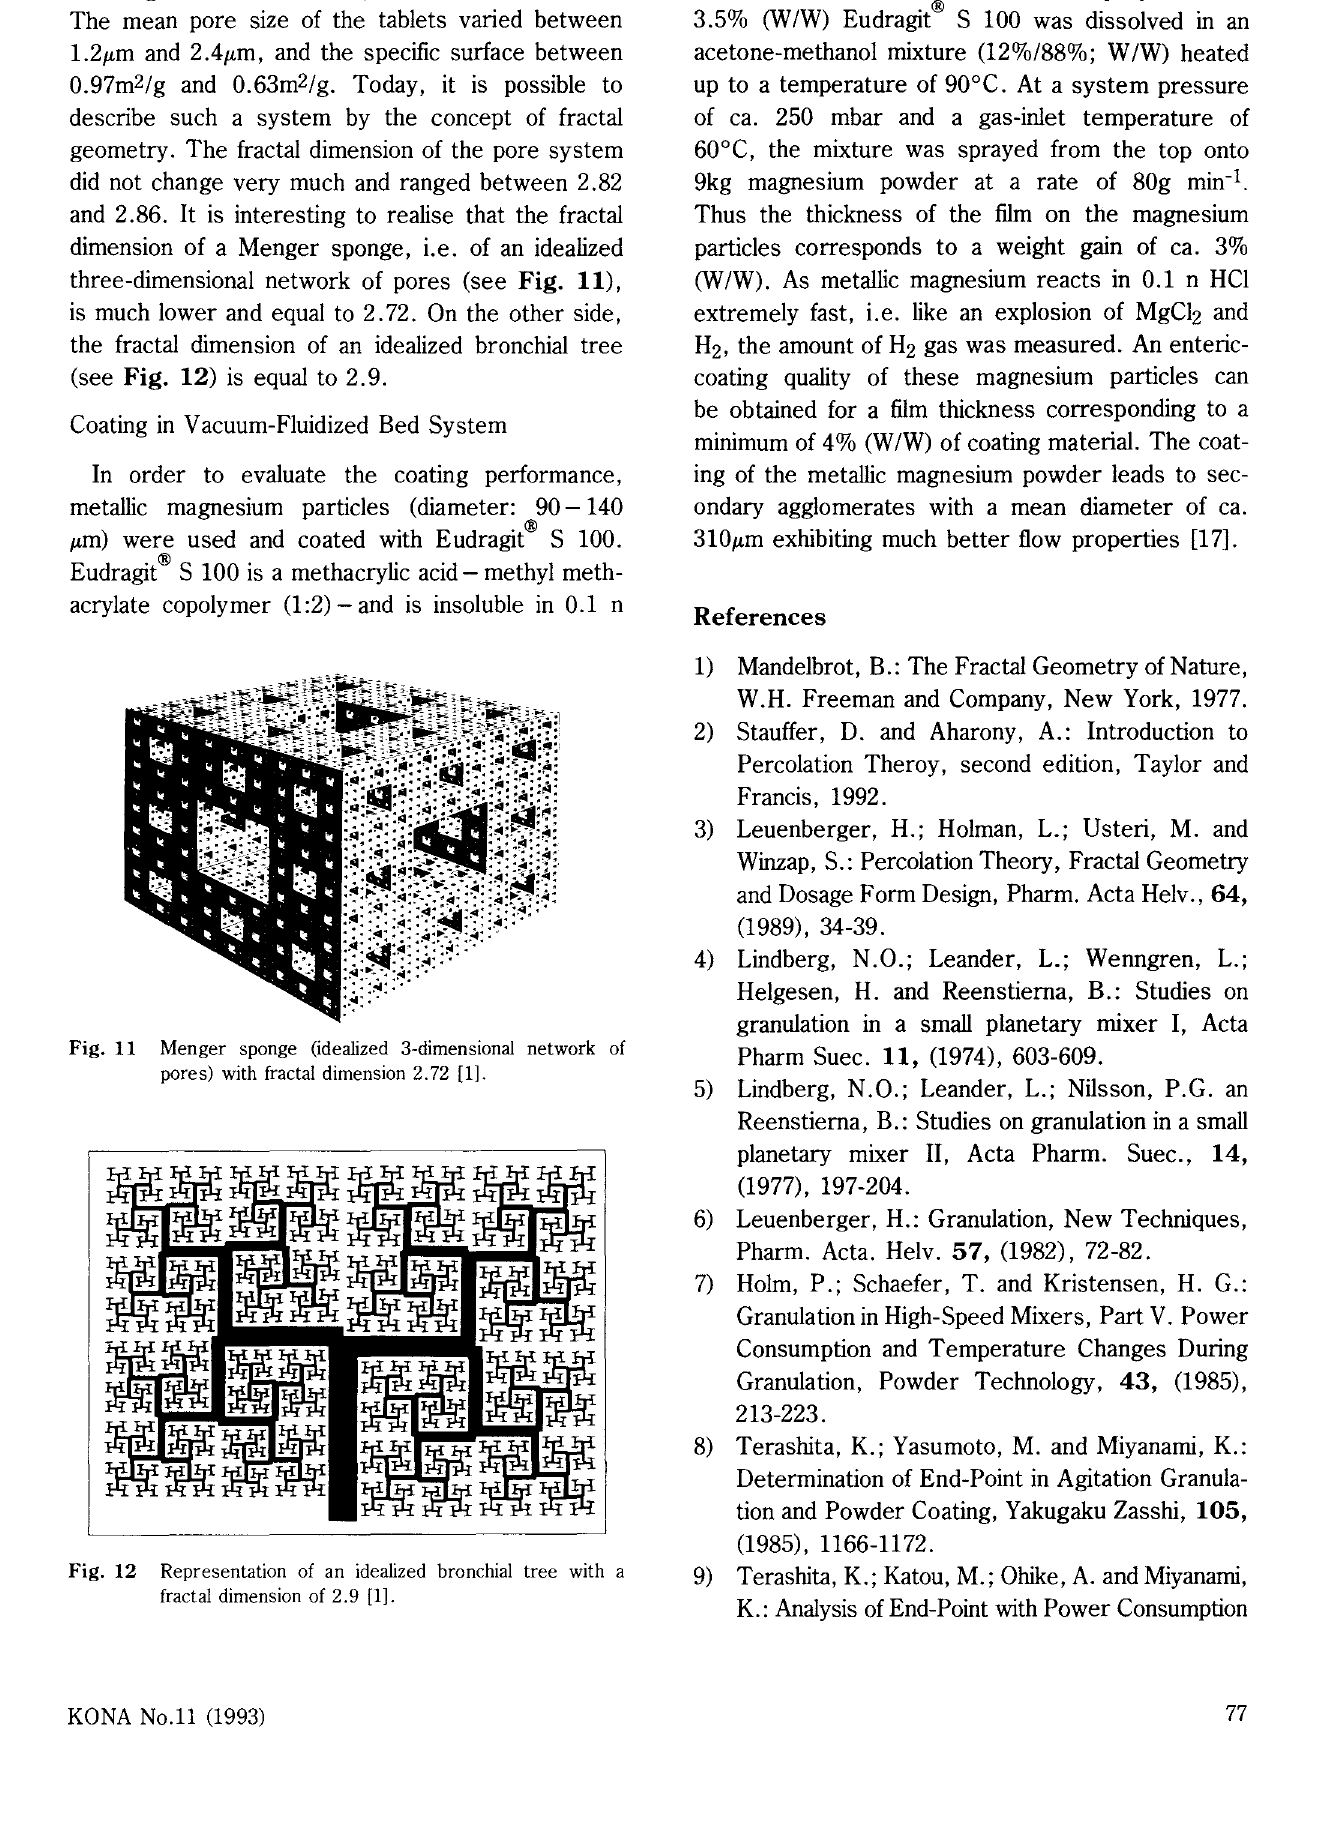
Fig. 12 Representation of an idealized bronchial tree with a fractal dimension of 2.9 [1].